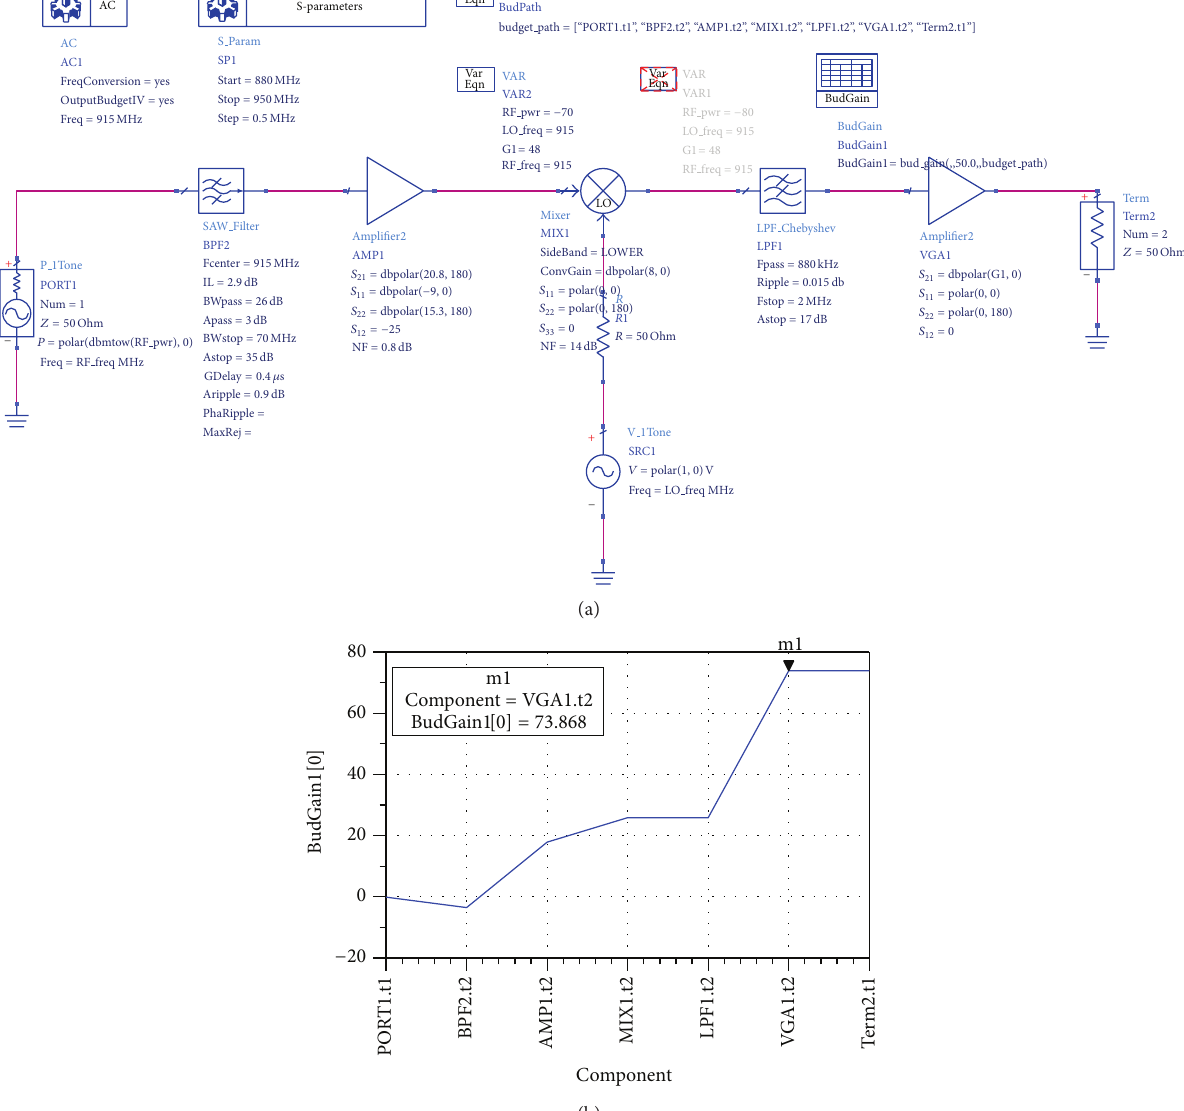
and receives the backscattered signal from tag in the same frequency band simultaneously. This characteristic results